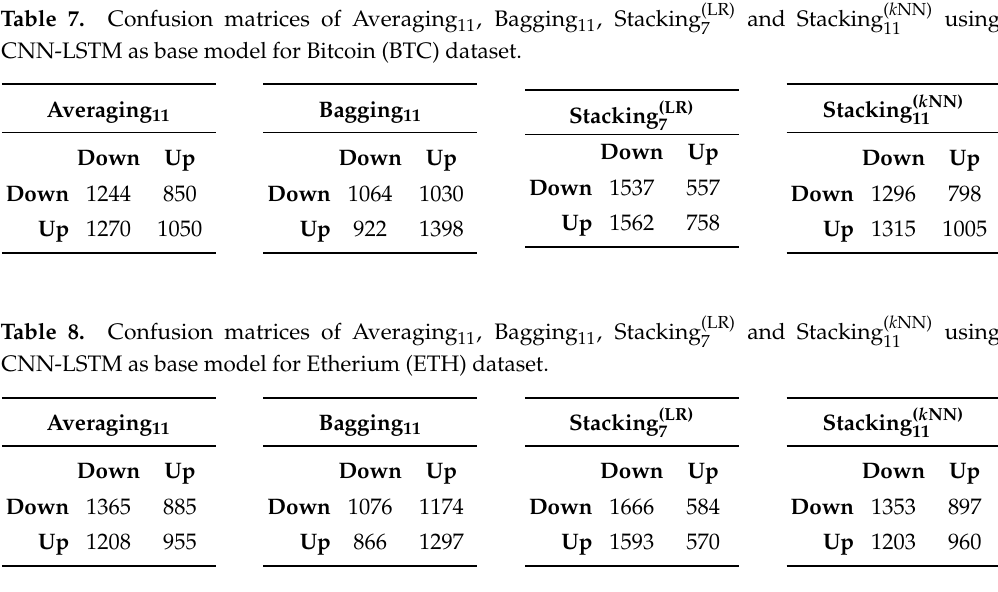
and Stacking ( k NN) using 7 11